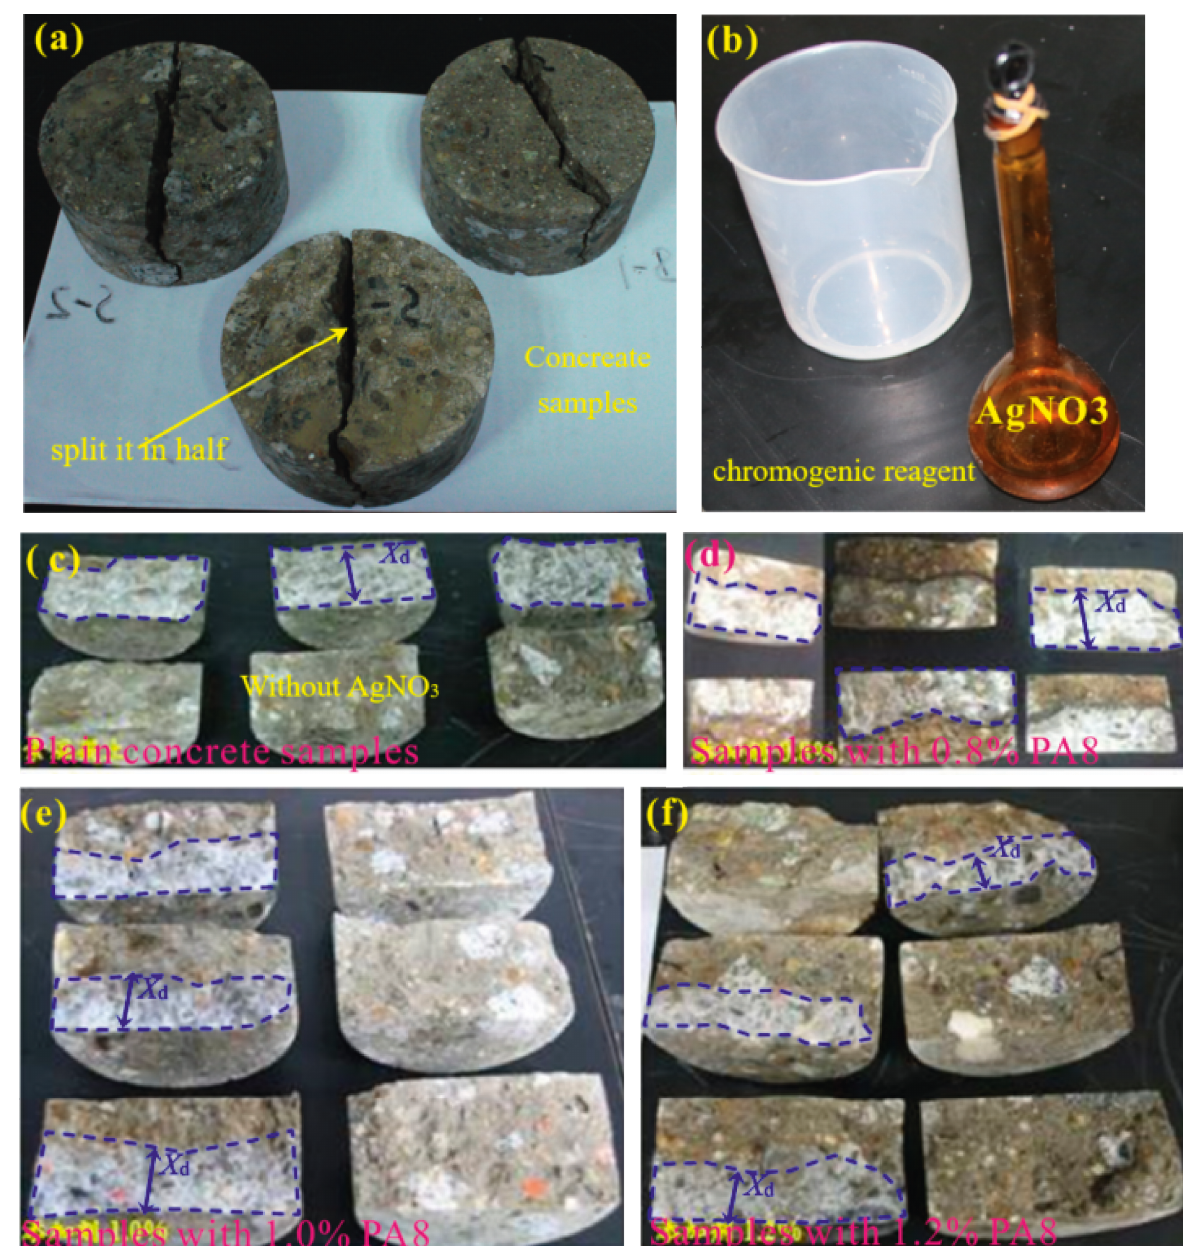
Figure 5: The chloride ion penetration results of the rapid chloride migration (RCM) test: (a) concrete samples with two halves, (b) silver nitrate (AgNO3) solution, (c) result of color appearance for plain concrete samples, (d) result of color appearance for special concrete samples with 0.8% PA8 content, (e) result of color appearance for special concrete samples with 1.0% PA8 content, and (f) result of color appearance for special concrete samples with 1.2% PA8